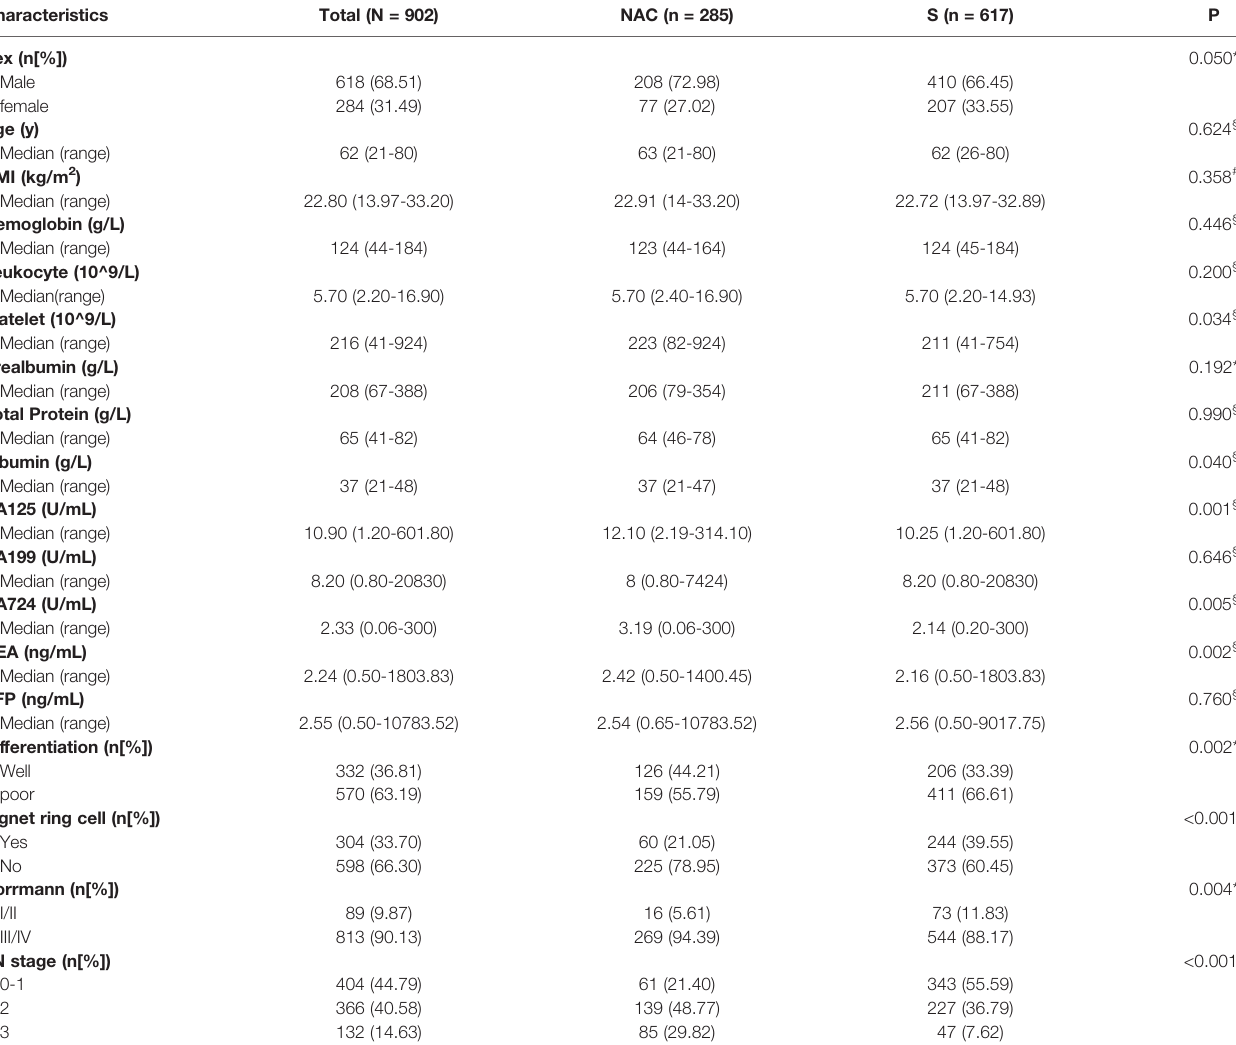
TABLE 1 | Pretreatment clinical characteristics of LAGC (cT4NxM0) patients before 1:1 matched.